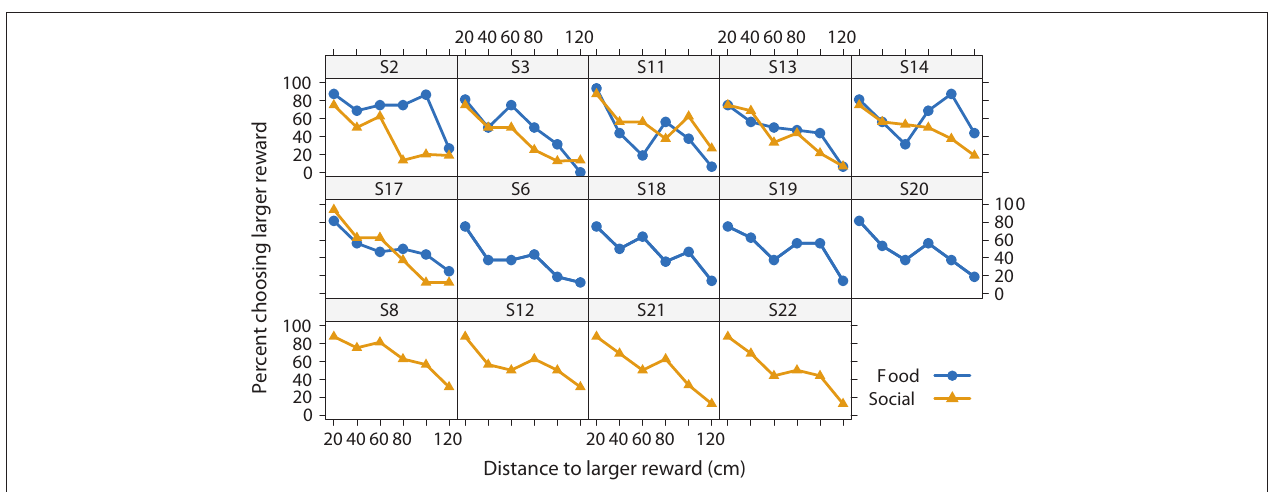
Figure 4 | effect of reward type on spatial discounting for each subject. Choice for the larger reward decreased with the distance to the larger reward for each subject both in the food (blue circle) and social conditions (yellow triangles). Six subjects experienced both conditions, and eight subjects only experienced